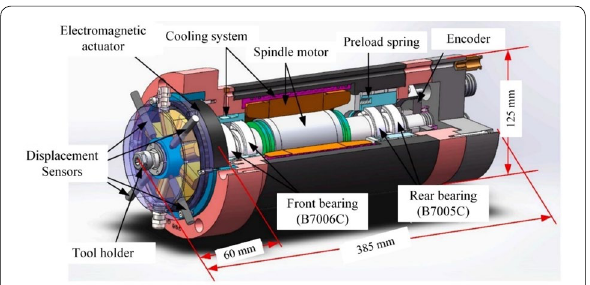
Figure 39 The integrated structure of electromagnetic ring